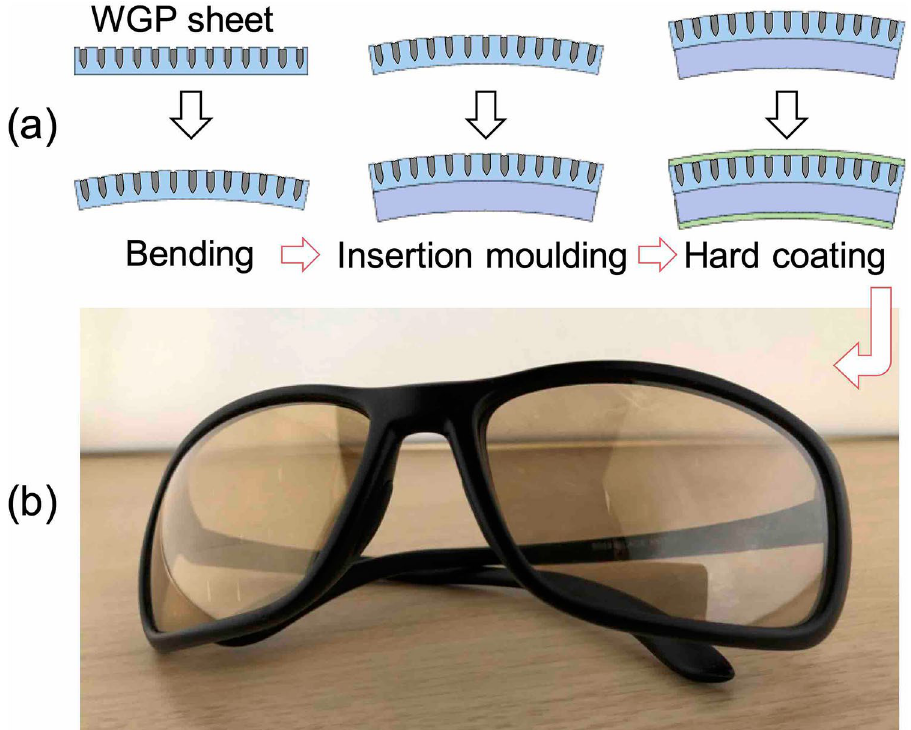
Figure 11. a A process flow for polarised sunglasses. b Photograph of the polarised sunglasses using the printed low-reflective WGP